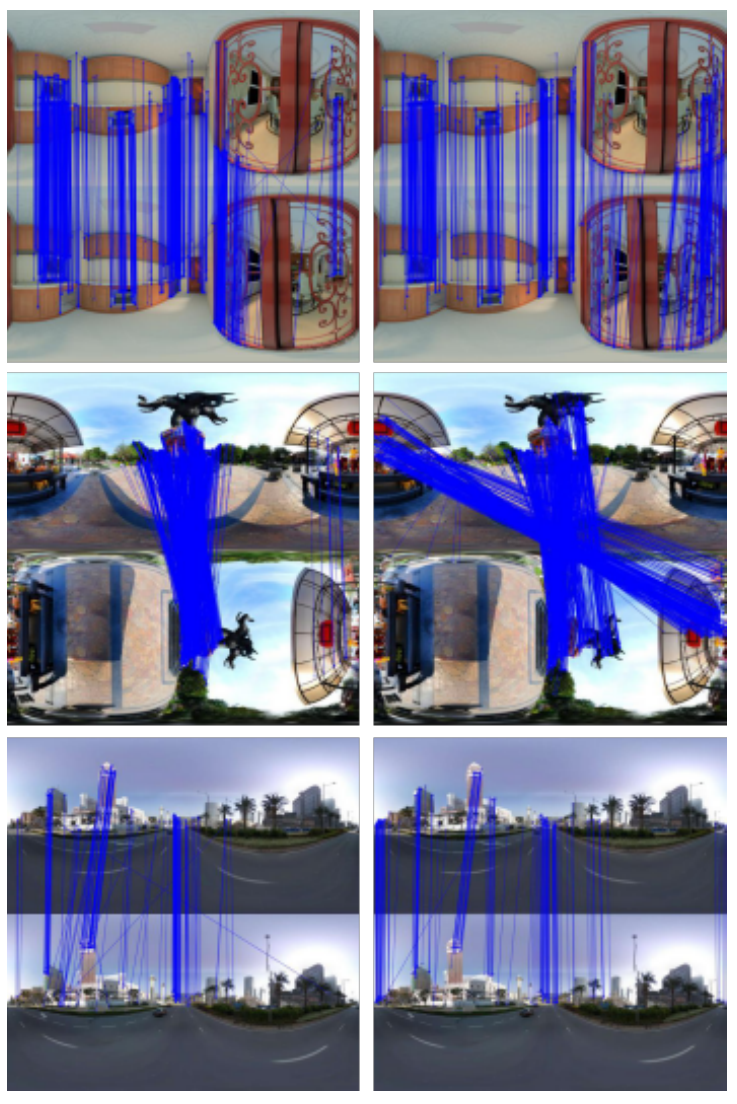
Figure 9. ( left ) Oriented FAST and Rotated BRIEF (ORB); ( right ) SPHORB. Table 2. Evaluation of matching results for ORB and